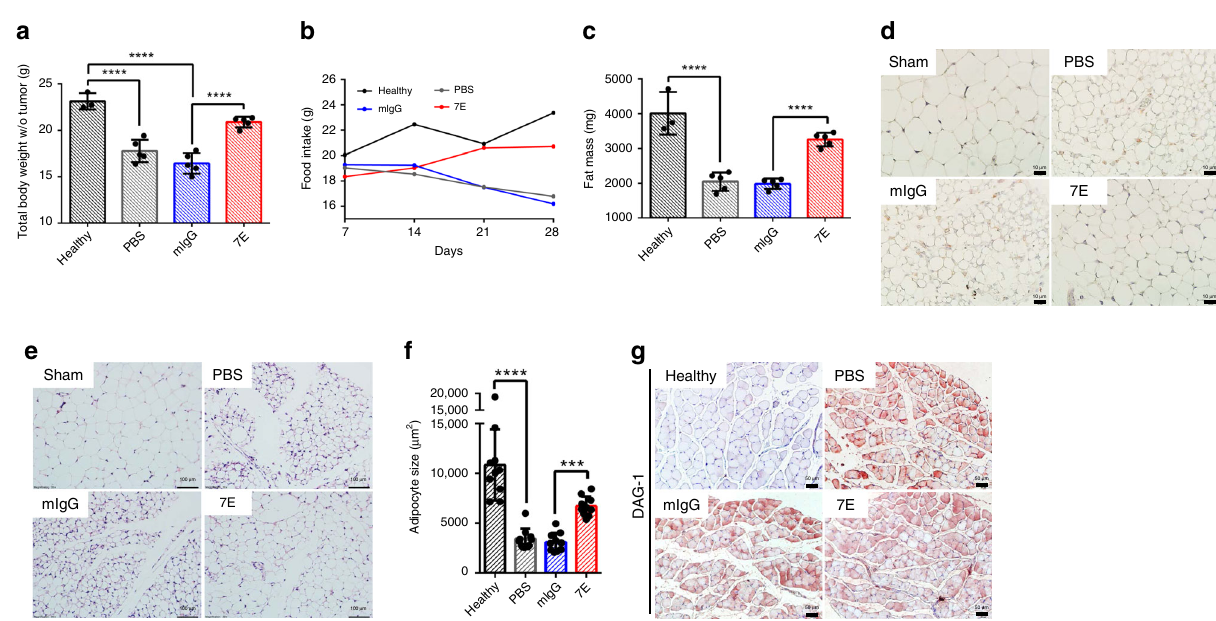
Fig. 5 7E reversed fat mass loss in an orthotopic model of pancreatic cancer. KPC/Luc cells were injected into the pancreas of mice. PBS, mIgG, or 7E ( n = 5) was injected (i.p.) into the mice twice per week for 28 days. Mice not injected with cancer cells served as healthy controls ( n = 3). a The tumor-free body weight of the mice was measured on day 28. One-way ANOVA, p < 0.0001; **** p < 0.0001. b The food intake of the mice was monitored every week. Data are shown as the mean. c Epididymal fat was excised and weighed. One-way ANOVA, p < 0.0001; **** p < 0.0001. d IHC staining for F4/80 + macrophages in the epididymal fat of orthotopic model mice was performed. Original magni fi cation: ×400; scale bar, 10 μ m. e Representative images of